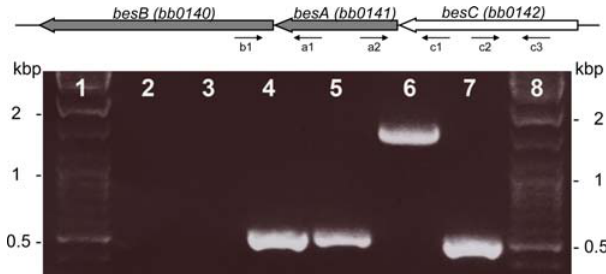
Figure 1. Schematic representation of the putative besB-besA- besC operon in Borreliaburgdorferi genome and results from the reverse transcription PCR. Lane 1 and 8; molecular weight markers, lane 2; PCR reaction without template using primer pair c2 and c3 served as negative control, lane 3; primer pair c2 and c3 in ordinary PCR reaction using RNA as template served as negative control for DNA contamination, lane 4; primer pair b1 and a1, lane 5; primer pair a2 and c1, lane 6; primer pair b1 and c1, lane 7; primer pair c2 and c3 served as positive control.